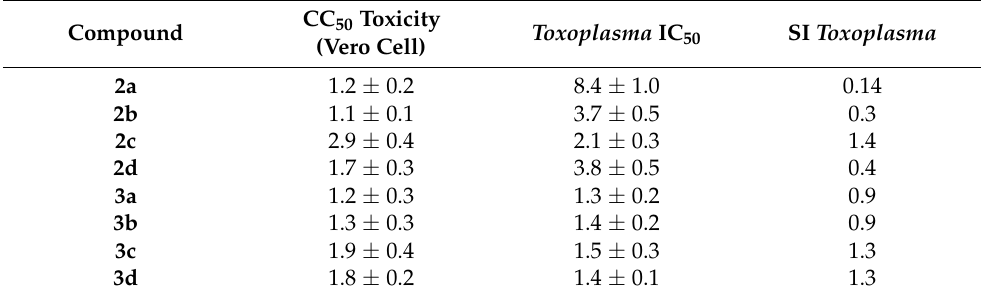
Table 5. Antitoxoplasmal activity of selected compounds against T. gondii in IC 50 and CC 50 of µ M mL − 1 of mean ±